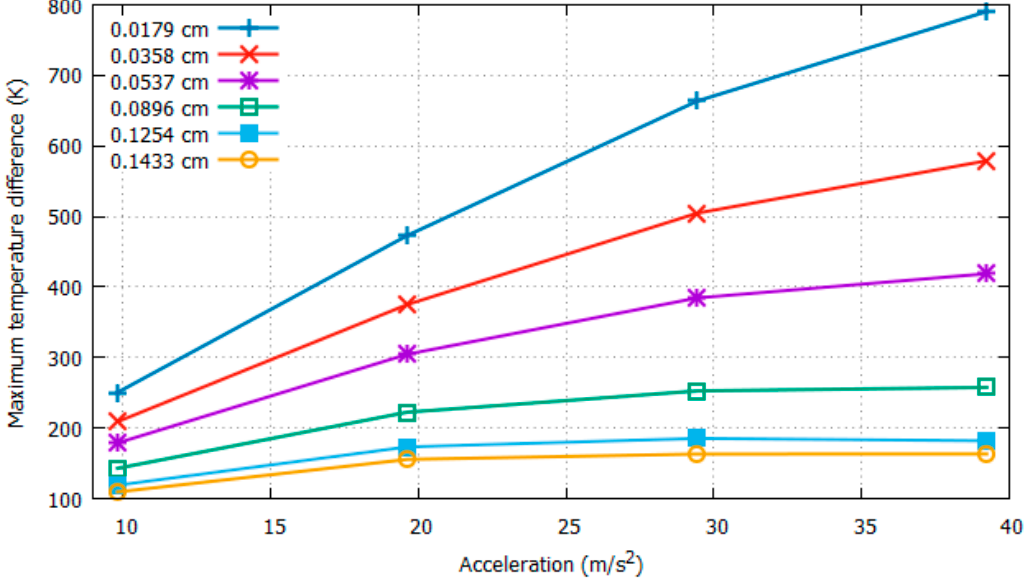
Figure 9. ∆ T_Y max w.r.t acceleration at 12.57 rad/s with varying distance between heater and sensors.